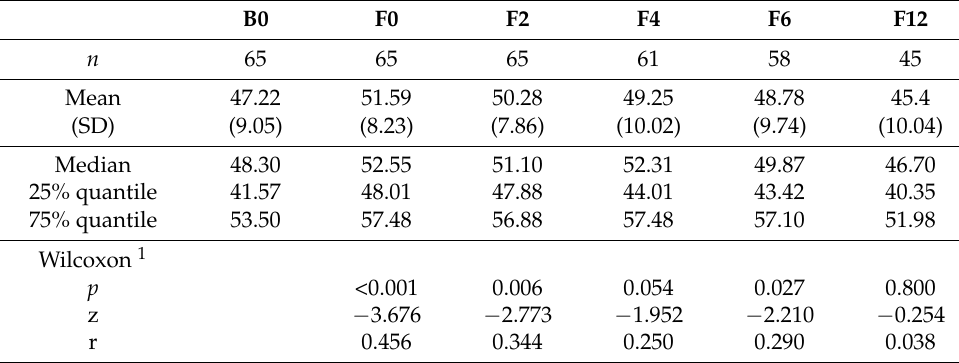
Table 4. Development of MCS, using Wilcoxon signed-rank test.